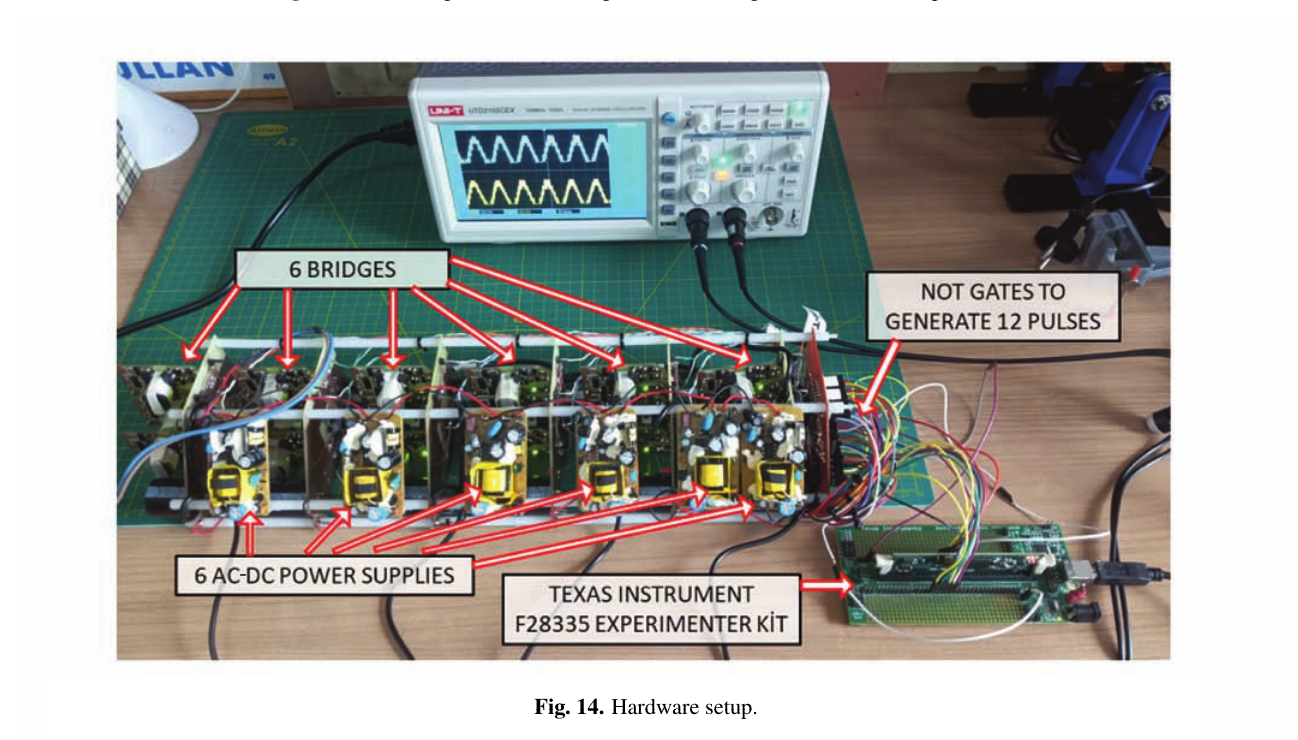
Fig. 13. Circuit diagram of Fig 14 Hardware setup Fig. 14. Hardware